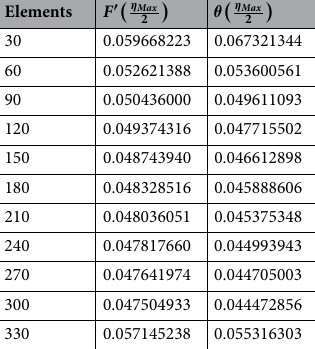
Maleki et al. 6 − ( Re ) 1 m + 1 C